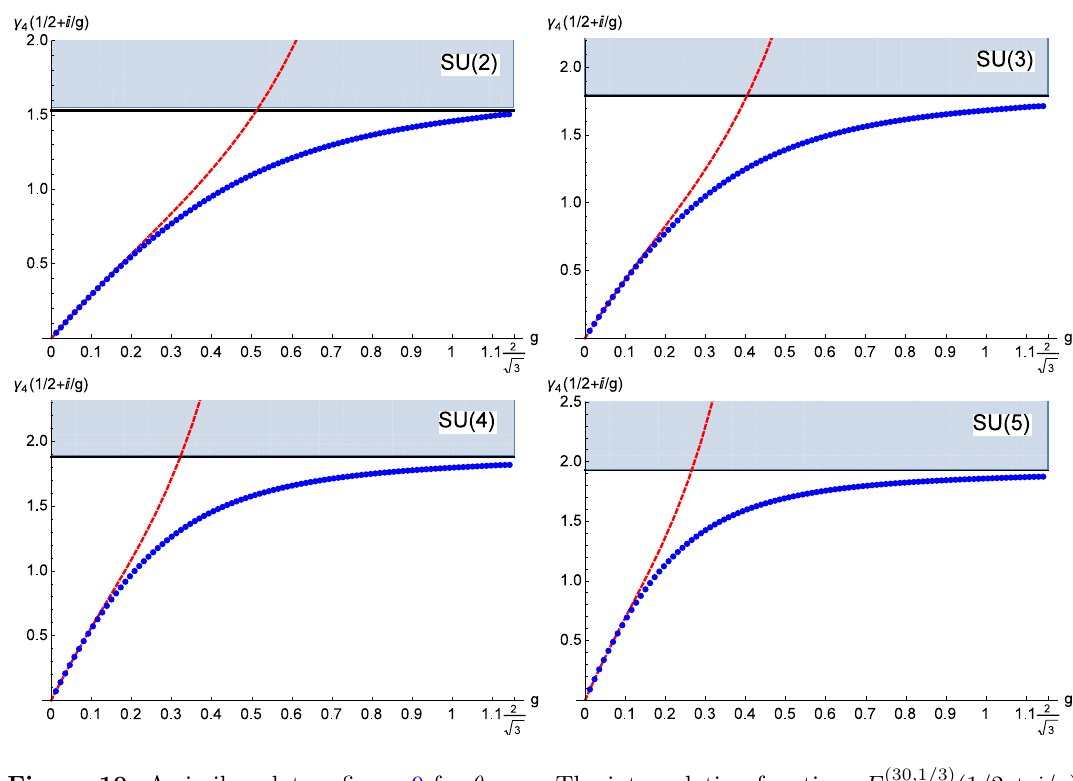
Figure 10 . A similar plot as (cid:12)gure 9 for (cid:18) = (cid:25) . The interpolating functions F (30 ; 1 = 3) for the spin-4 operator is plotted as a function of g . Figure 11 . A similar plot for the spin-4 case as (cid:12)gure 5 and 8. The red dashed line shows 2 (cid:0) 48 = 25 N 2 , which is numerical (cid:12)tting of the corner values in the large- a regime